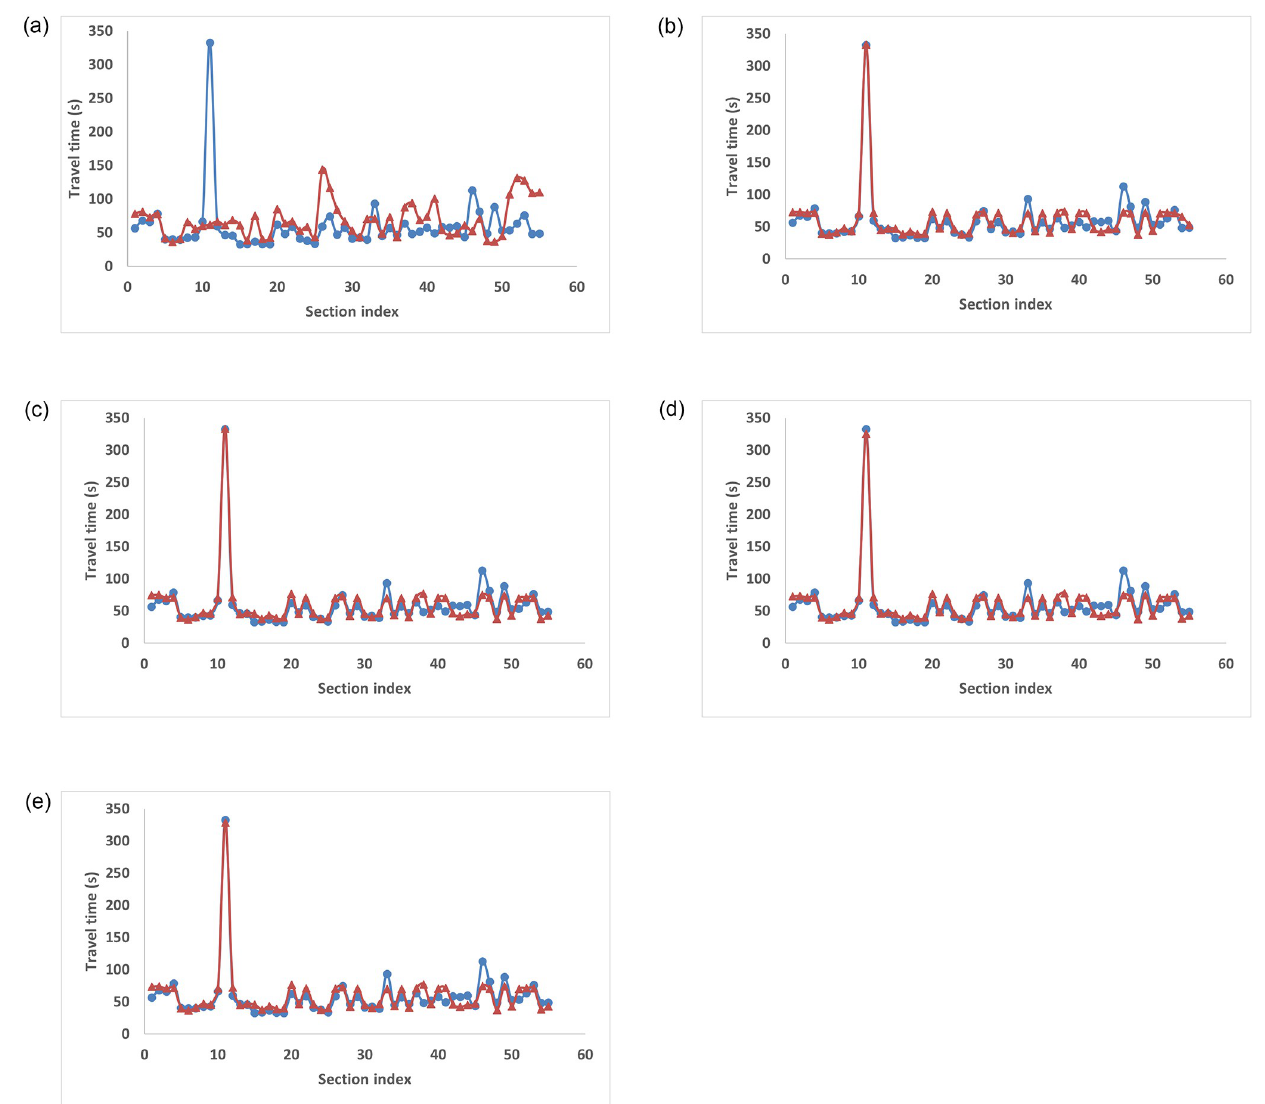
Fig 4. Measured and predicted travel times over iterations for the study stretch. (a) Iteration 0, (b) Iteration 1, (c) Iteration 2, (d) Iteration 3, (e) Iteration 4.